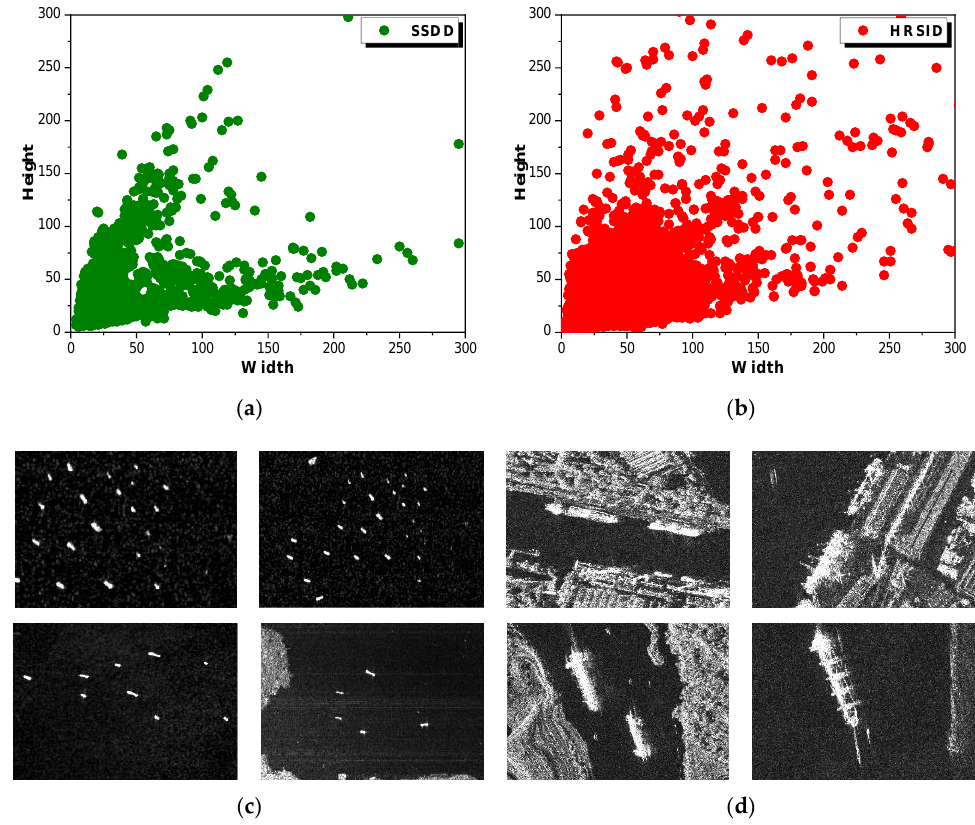
Figure 10. Some cross-scale SAR ships. ( a ) Ship size distribution in SSDD. ( b ) Ship size distribution in HRSID. ( c ) Small ships. ( d ) Large ships.